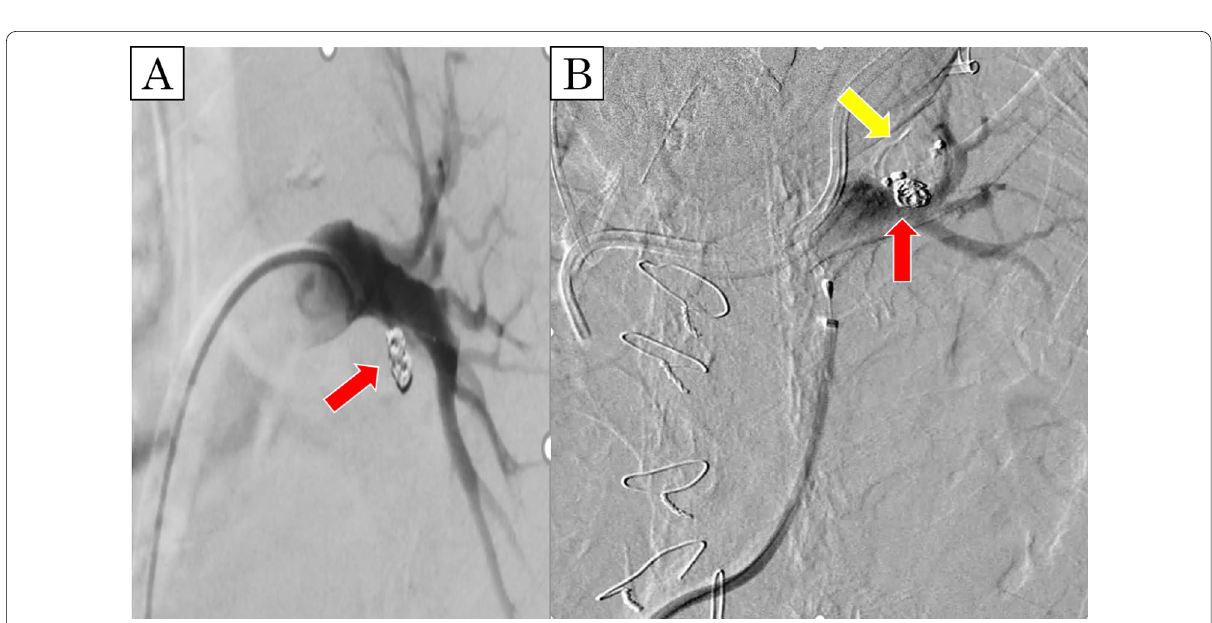
Fig. 3 Angiography findings. A Angiography showing the pulmonary aneurysm treated by emergency endovascular coil embolization with the use of N -butyl cyanoacrylate (red arrow indicates a coil). B Angiography performed immediately after central embolization of the left main pulmonary artery using an Amplatzer vascular plug (St. Jude Medical, MN, USA) (yellow arrow indicates a vascular